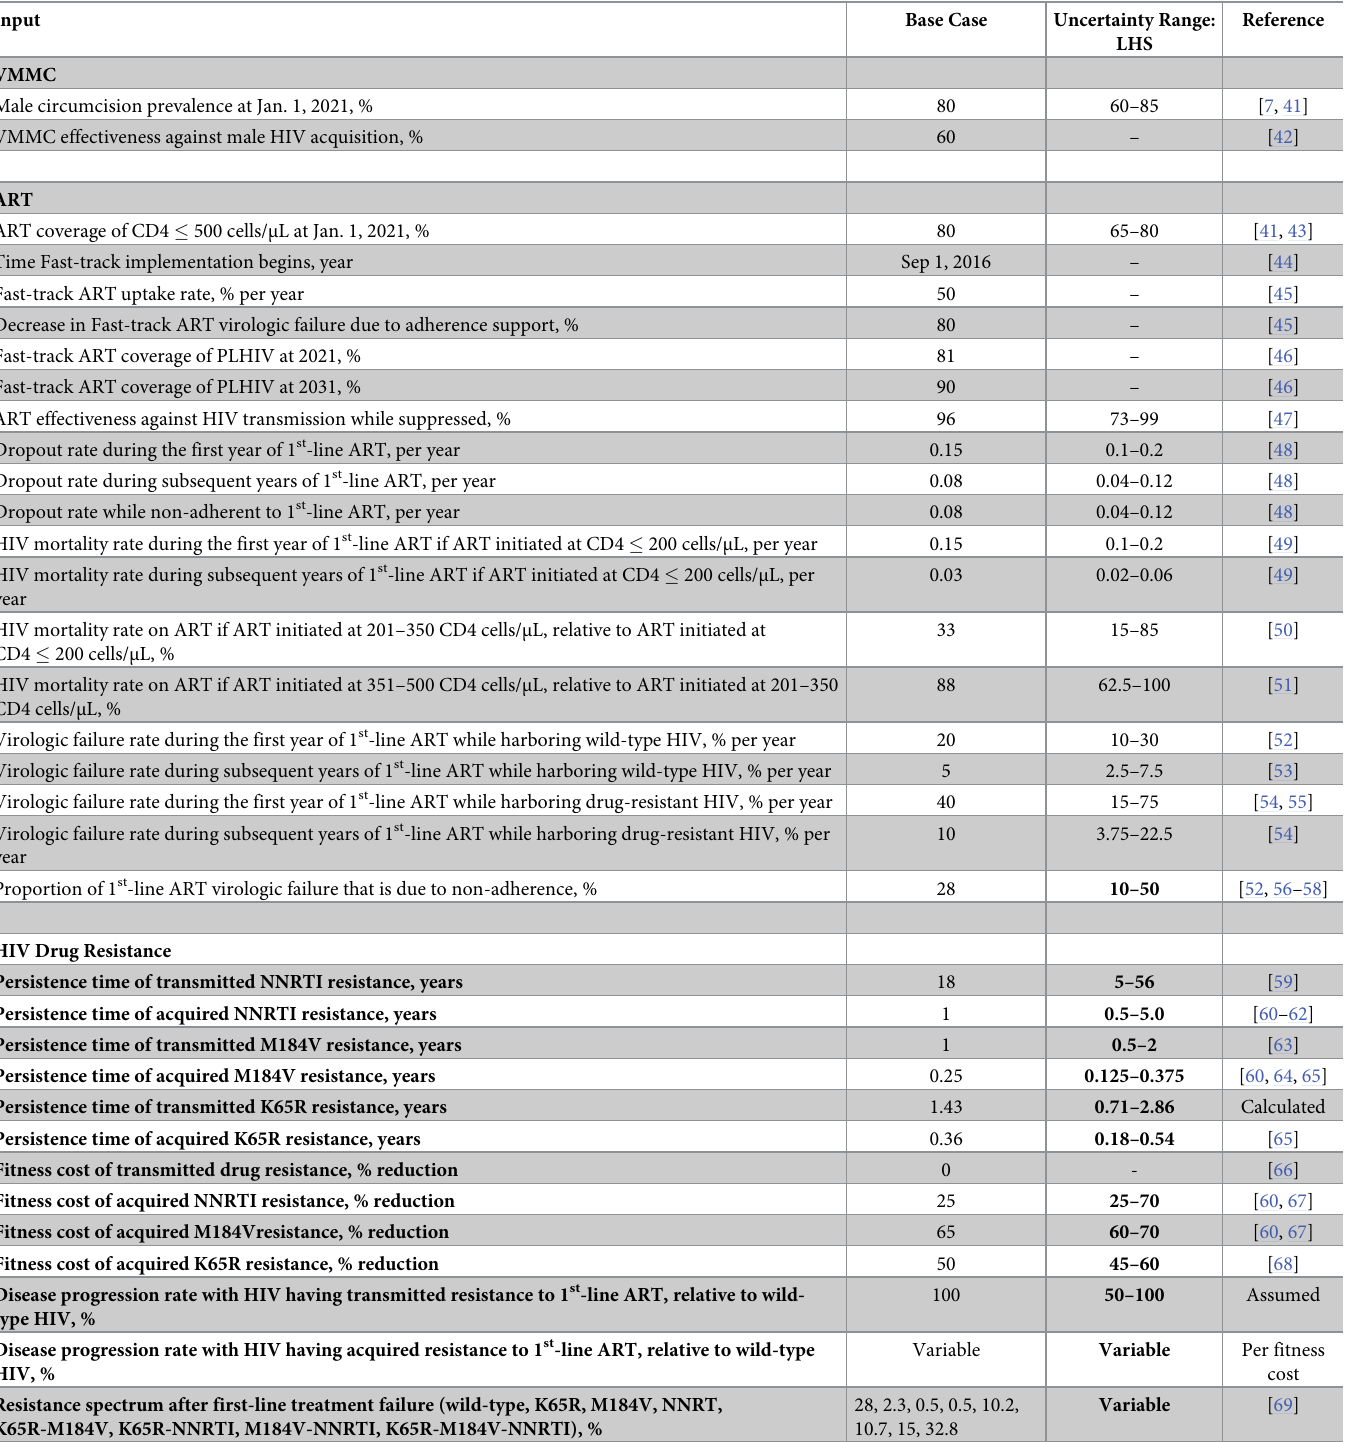
Table 1. Key intervention-related model